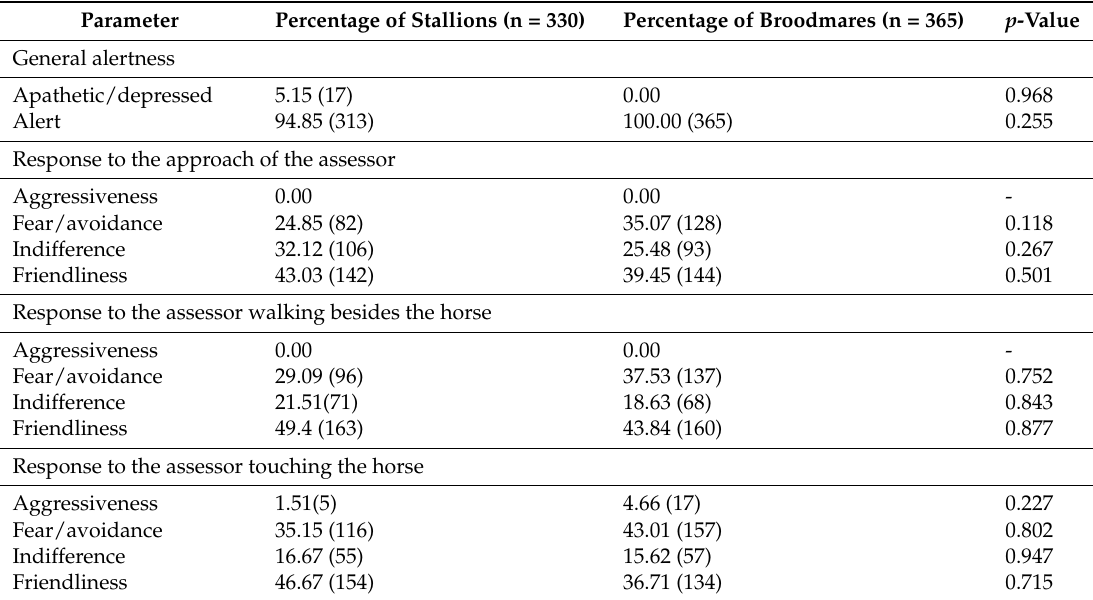
Table 6. The prevalence of behavioral parameters assessed in each breeding horse category.